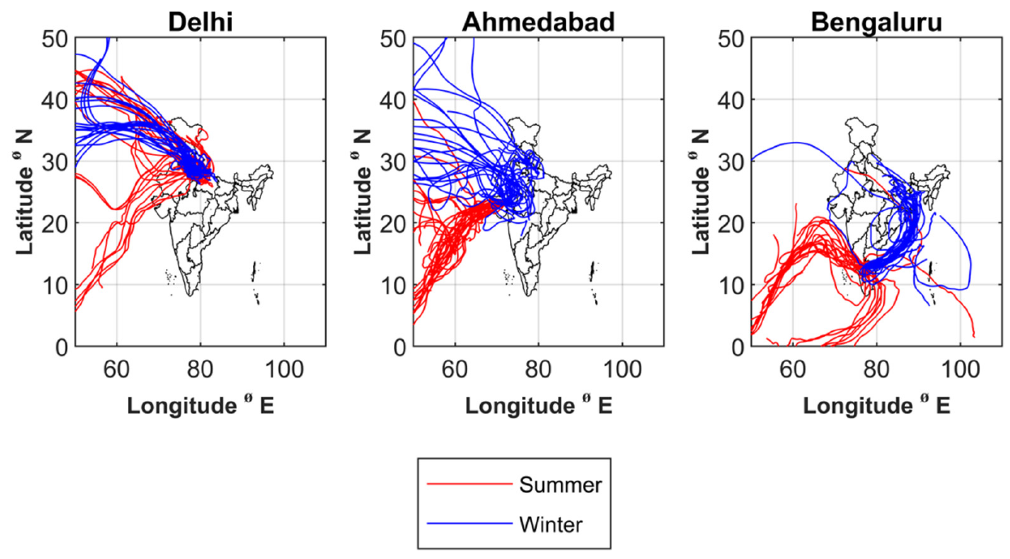
Figure 5. Ten-day HYSPLIT backward trajectories over the study locations.